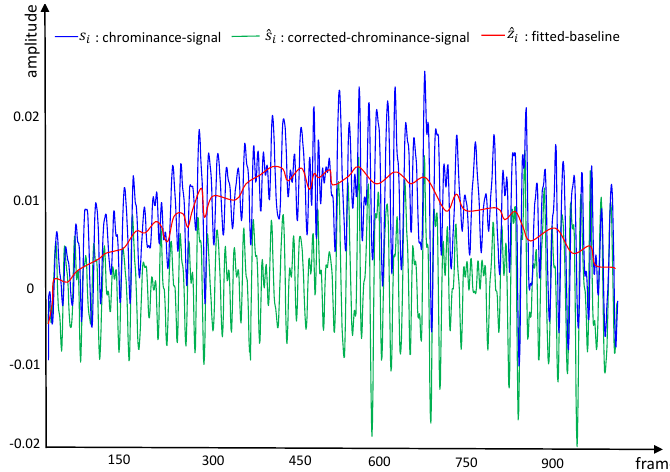
Figure 3. The de-trending filter of chrominance signal. The blue curve is the chrominance signal, the green curve is the corrected signal, and the red curve is the fitted baseline.